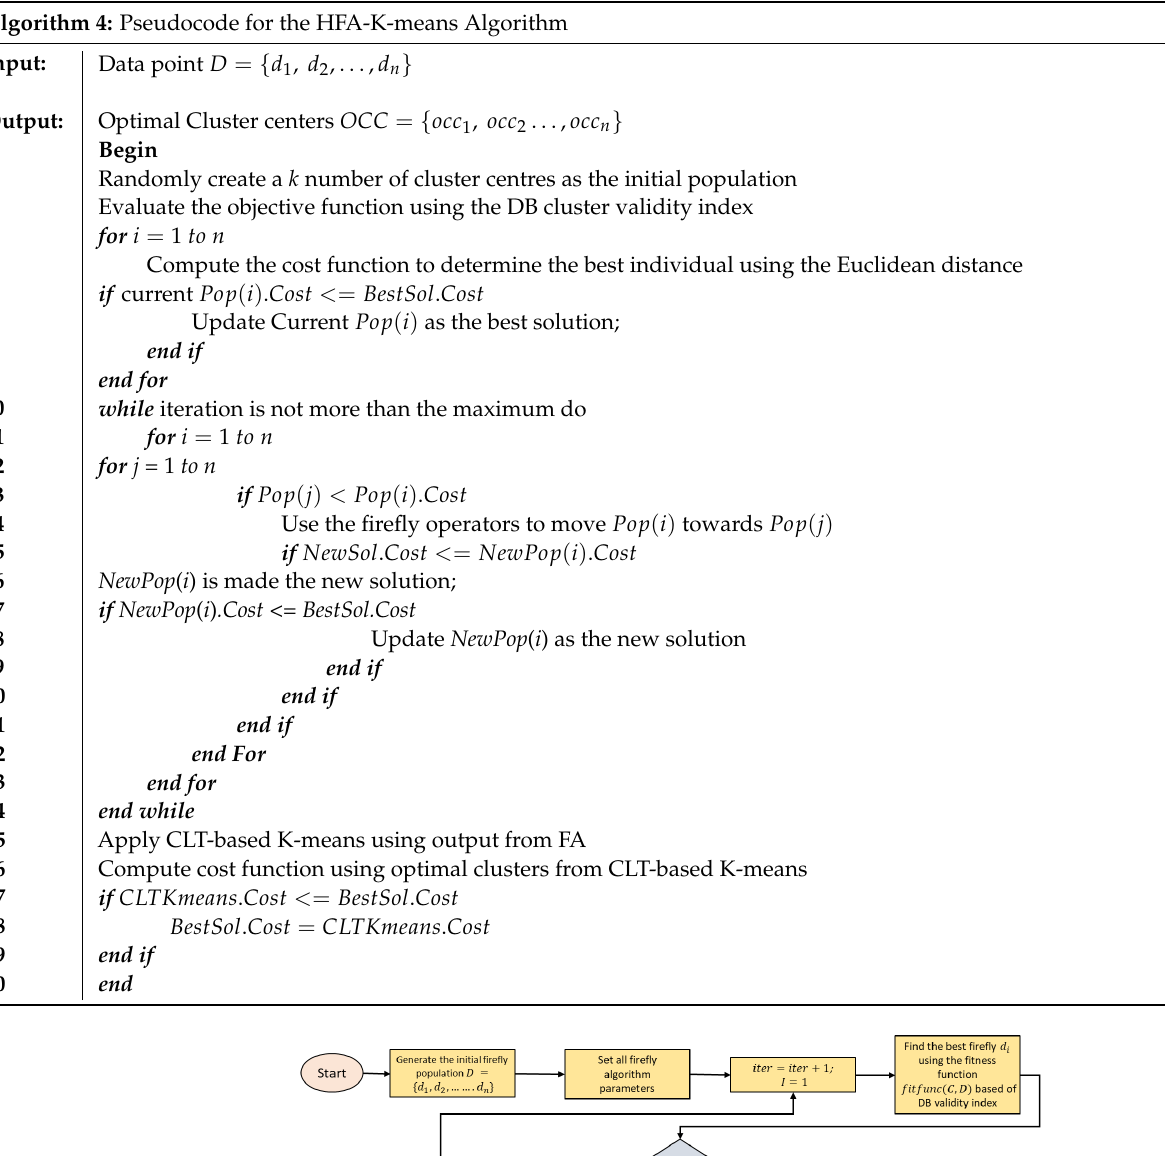
Algorithm 4: Pseudocode for the HFA-K-means Algorithm